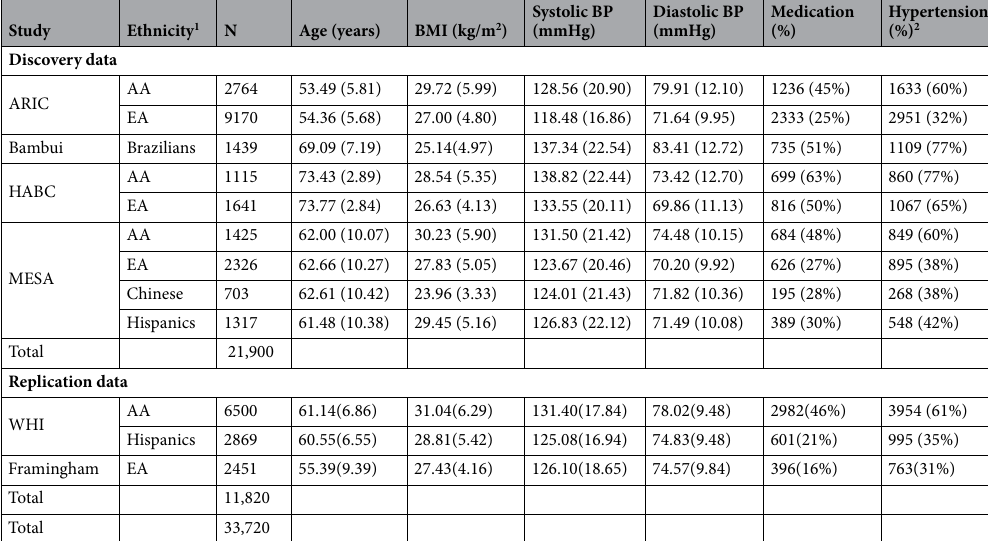
Table 1. Study participants’ baseline characteristics in the discovery and replication datasets. 1 AA = African Americans and EA = European Americans. 2 Hypertension was defined as SBP at least 140 mmHg, DBP at least 90 mmHg, or being on antihypertensive medication. Mean (SD) reported, except where